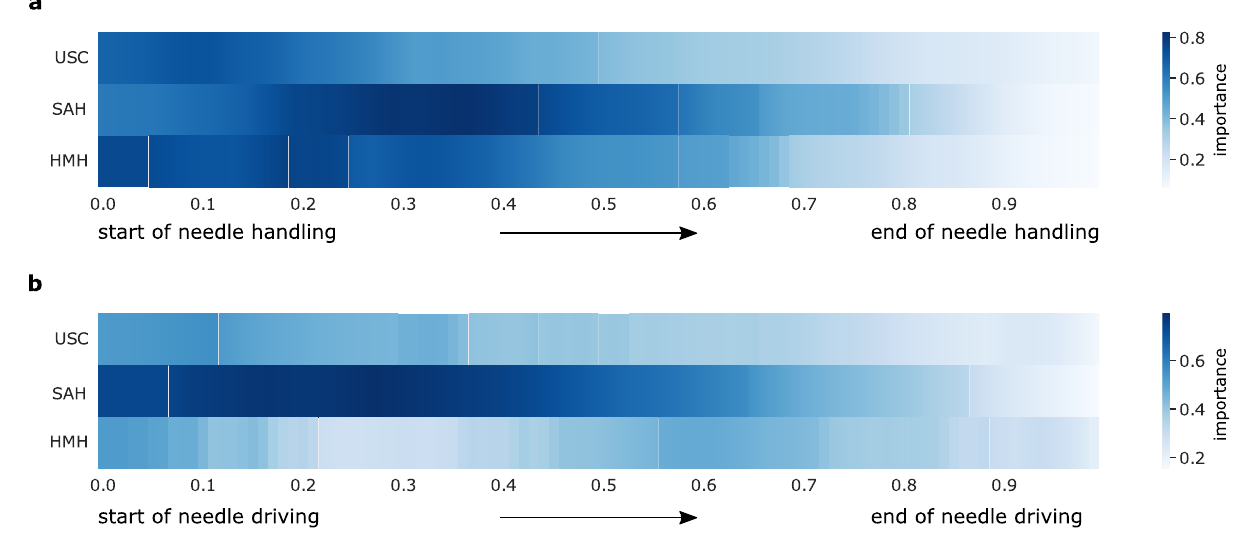
Fig. 1 Heatmap of the ground-truth explanation annotations across hospitals. We average the explanation annotations for the a , needle handling and b , needle driving video samples in the test set of the Monte Carlo folds (see Supplementary Table 2 for total number of samples), and present them over a normalized time index, where 0 and 1 re fl ect the beginning and end of a video sample, respectively. A darker shade (which ranges from 0 to 1 as per the colour bars) implies that a segment of time is of greater